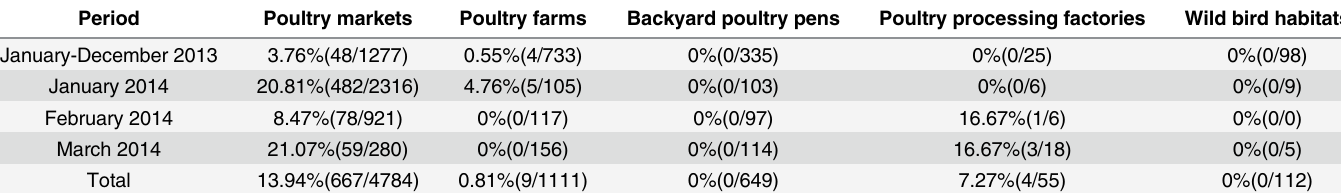
Table 1. Prevalence of H7N9 virus among samples from different sampling sites between January 2013 and March 2014.